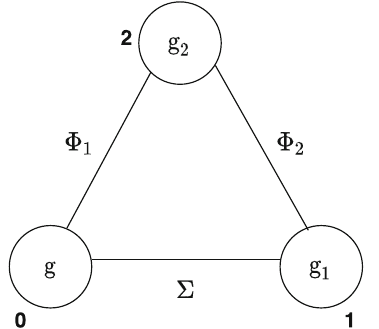
Fig. 1 Themodelunderconsiderationinthe“moose”notation.“Sites” 0 and 2 contain the (mostly) SM gauge group SU ( 2 ) × U ( 1 ) with the other SU ( 2 ) residing at site 1. The gauge couplings of the SU ( 2 ) × SU ( 2 ) × U ( 1 ) groups are denoted by g , g 1 and g 2 respectively. Sym- metry breaking in this model is engineered by two Higgs doublets Φ 1 , 2 and a non-linear sigma model field